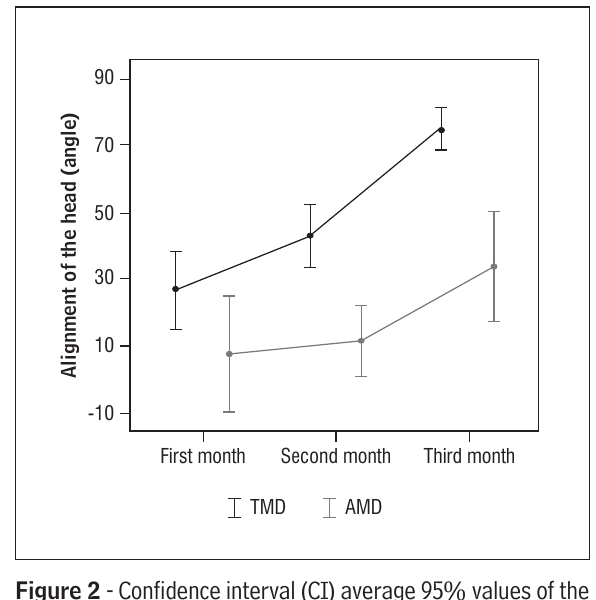
Figure 2 - Confidence interval (CI) average 95 % values of the alignment of the head during the second maximum straightening of the head in the prone groups with typical motor development (TMD, n = 6 at each age) and atypical motor development (AMD, n = 4 in the first and second months and n = 3 in the third month) at each age